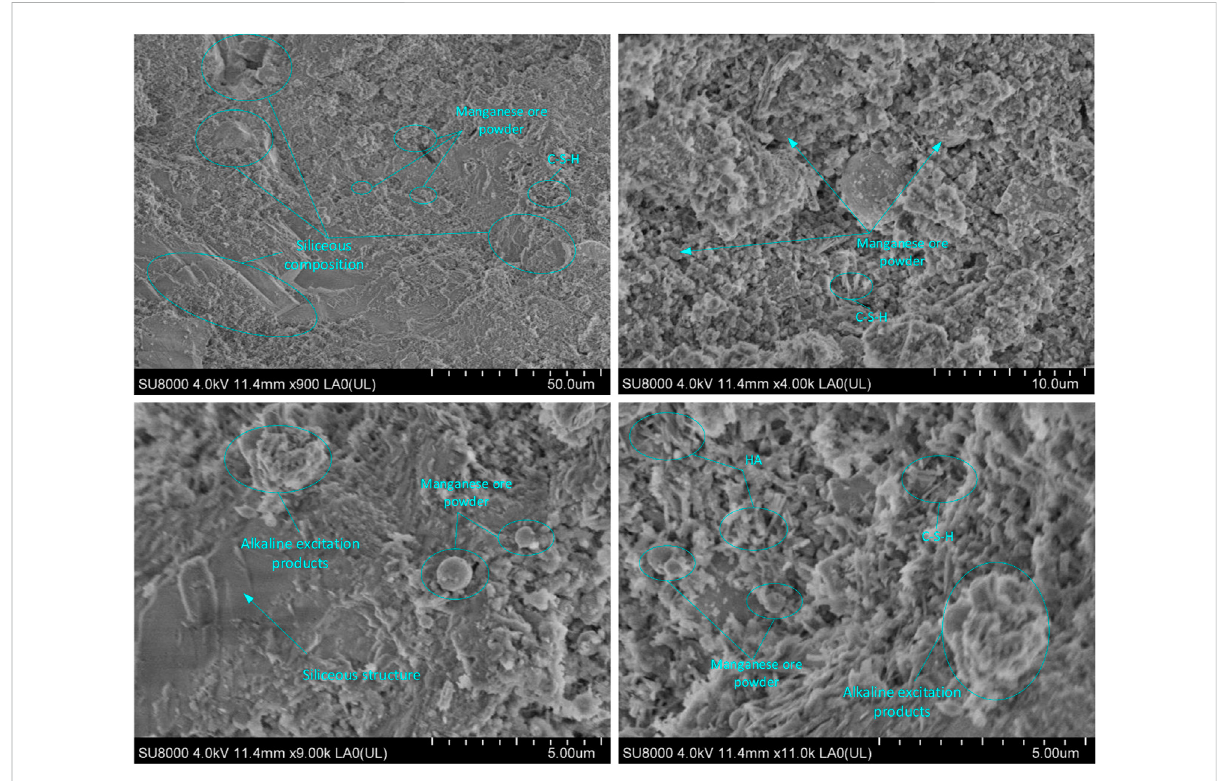
FIGURE 17 Microstructure of non-corrosive zone of high density BFs-HA-composite emulsion base cement